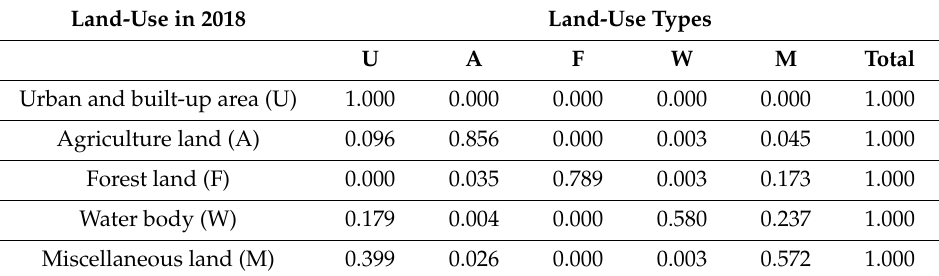
Table A8. Transition probability matrix for land-use change between 2016 and 2018. Land-Use in 2018